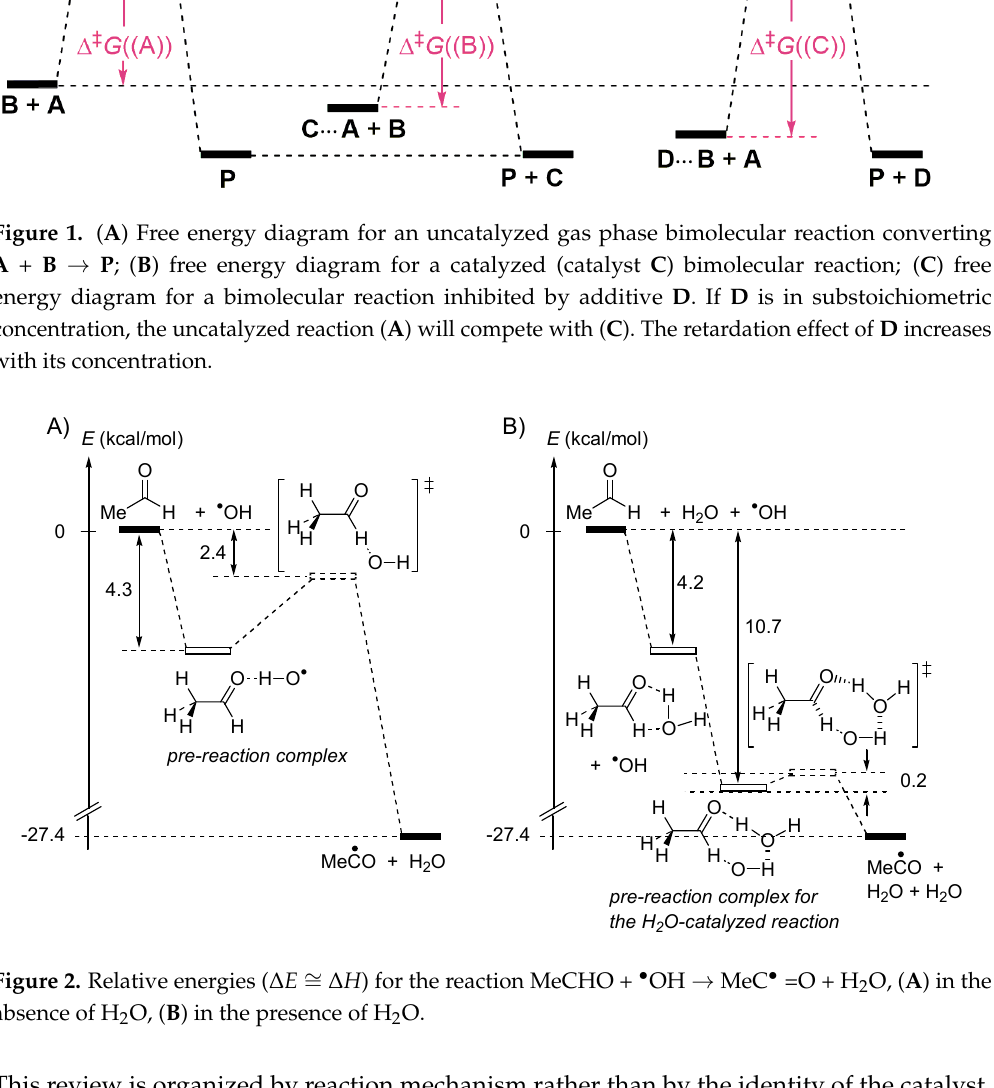
the uncatalyzed reaction ( A ) will compete with ( C ). The retardation effect of D increases with its concentration.